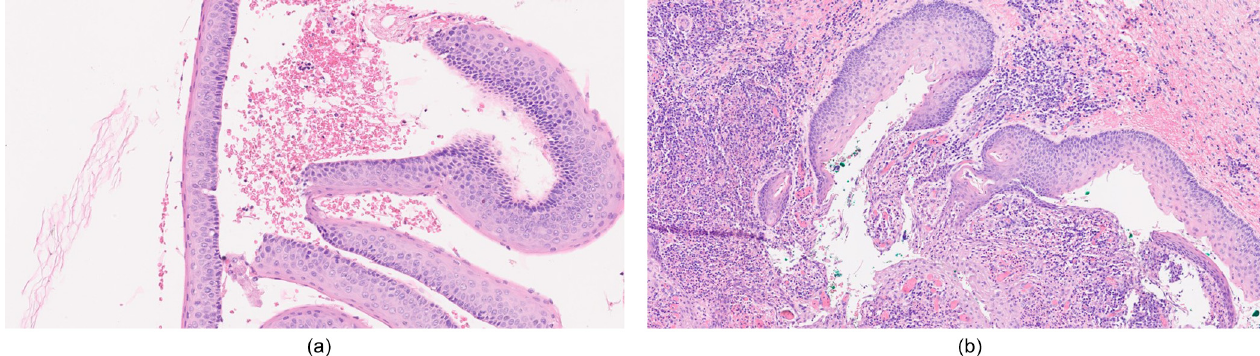
Fig. 7. Histological sections of an OKC before and after decompression (20 (cid:1) magni fi cation, Haematoxylin and Eosin staining). Thickening of the membrane is not signi fi cant in this case, but an important in fl ammatory change can be seen. (a) Before decompression protocol. (b) After